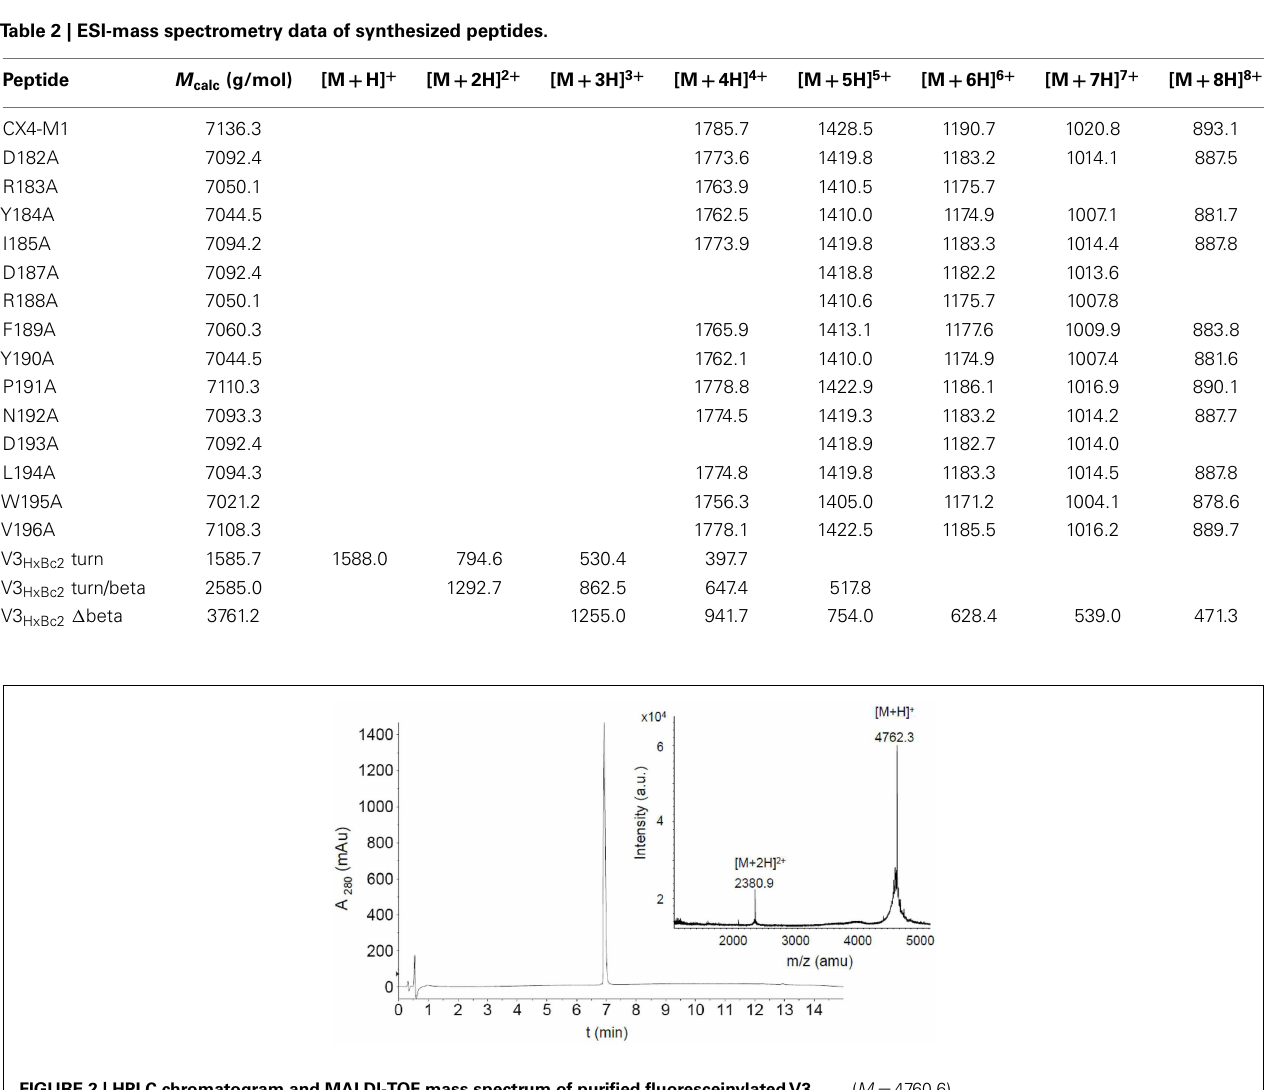
FIGURE 2 | HPLC chromatogram and MALDI-TOF mass spectrum of purified fluoresceinylatedV3 HxBc2 . ( M = 4760.6).